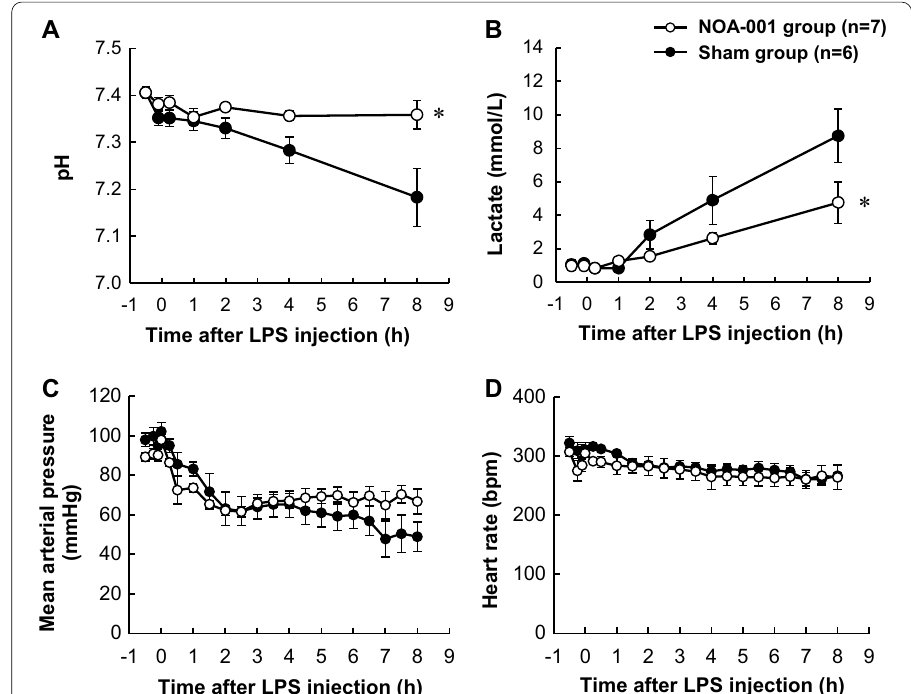
Fig. 5 Changes in a arterial blood pH, b lactate levels, c mean arterial pressure and d heart rate. Data are shown as mean SEM. * p < 0.05 for NOA-001 vs. sham by two way ANOVA with a Sidak post hoc test or Tukey ± post hoc